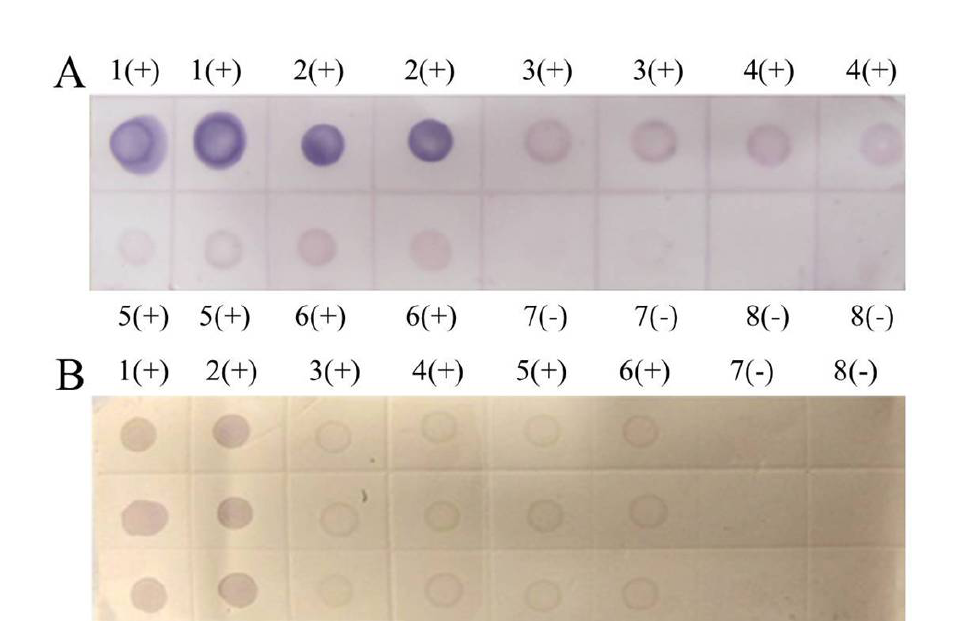
Figure 7. (A) Dot-ELISA test (PVDF membrane) results from Tianzhu Guizhou Province and Liangping Chongqing City. 1(+): Positive control. 2(+): Positive control. 3(+): Sample I from Tianzhu. 4(+): Sample II from Tianzhu. 5(+): Sample III from Tianzhu. 6(+): Sample from Liangping. 7(-): Negative control (stem). 8(-): Negative control (root). (B) Dot-ELISA test (NC membrane) results from Tianzhu and Liangping. 1(+): Positive control. 2(+): Positive control. 3(+): Sample I from Tianzhu. 4(+): Sample II from Tianzhu. 5(+): Sample III from Tianzhu. 6(+): Sample from Liangping. 7(-): Negative control (root). 8(-): Negative